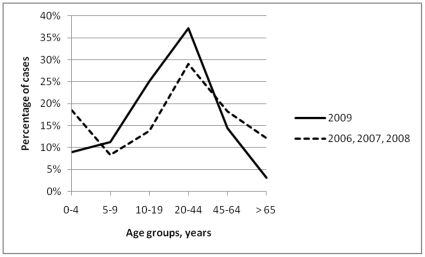
Percentile distribution by age group of notifications for laboratory-confirmed influenza in Australia, during 2009 (H1N1) pandemic influenza and the 3 previous influenza seasons combined.